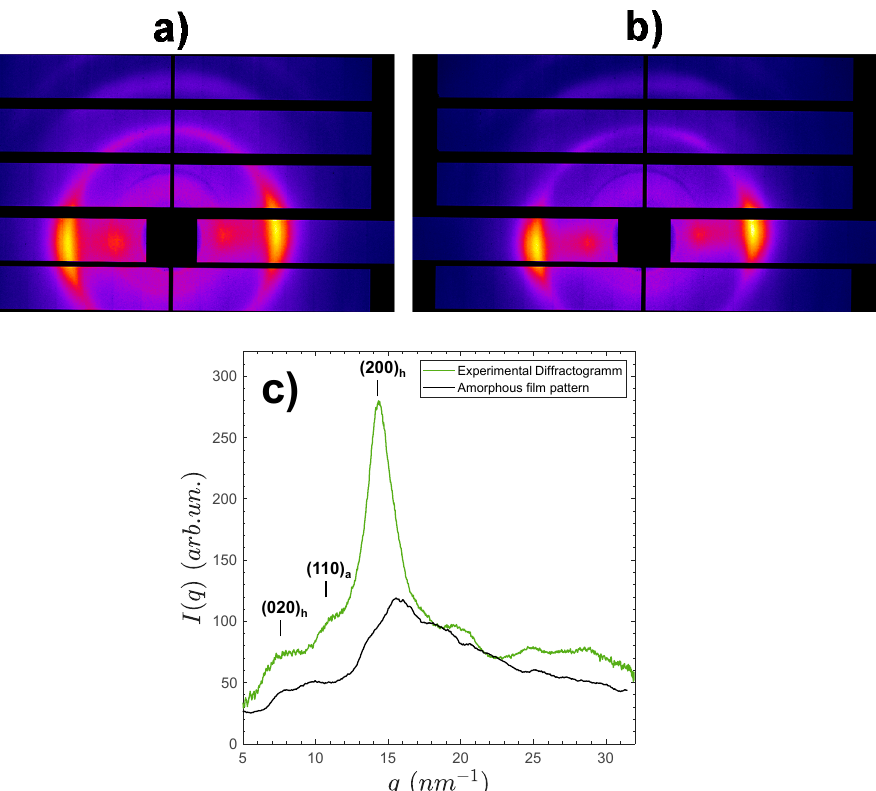
Figure 5. Synchrotron wide angle X-ray scattering (s-WAXS) 2D-patterns of fibers containing 1% of LMW chitosan, processed with a stretching ratio 𝜏 𝑡𝑜𝑡𝑎𝑙 of ( a ) 1.3 or ( b ) 1.9. The fiber axis was almost placed vertically. Apparent Herman’s orientation factors of ( a ) −0.205 (less oriented) and ( b ) −0.238 (more oriented) were estimated for the most intense crystalline reflection (200) h . ( c ) radial average 1D scattered pattern ( 𝑤 𝐿𝑀𝑊 = 30%).